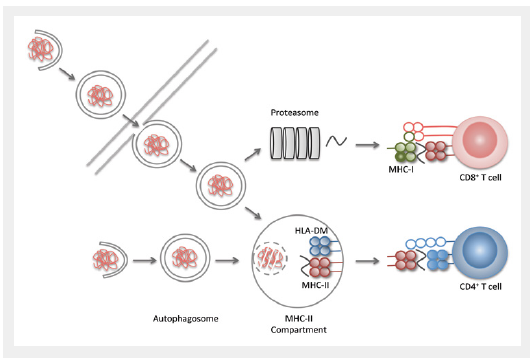
Macroautophagy in antigen processing for MHC presentation. Proteasomal products are primarily presented on MHC class I molecules to CD8 + T cells, while lyosomal products are preferentially presented on MHC class II molecules to CD4 + T cells. Macroautophagy seems to contribute to antigen presentation in at least three ways: i) it delivers cytoplasmic antigens for MHC class II presentation, ii) enhances phagosome maturation and iii) packages antigens in bystander cells for more efficient cross-presentation by antigen presenting